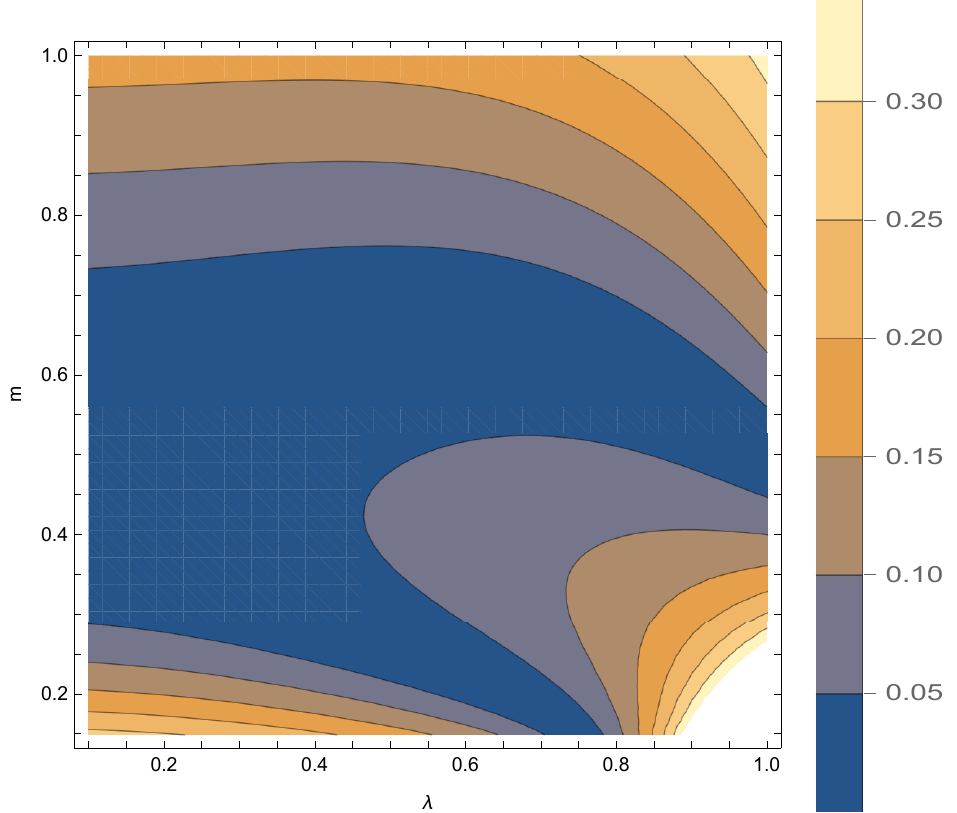
Figure 9. Contours of la Cierva’s surface. Observe that the Puig-Adam’s choice of parameters, λ = 1, m = 0.5 is indeed surrounded by a region of points with low k λ , m numbers. Notice that almost all the whole surface behaves stably.